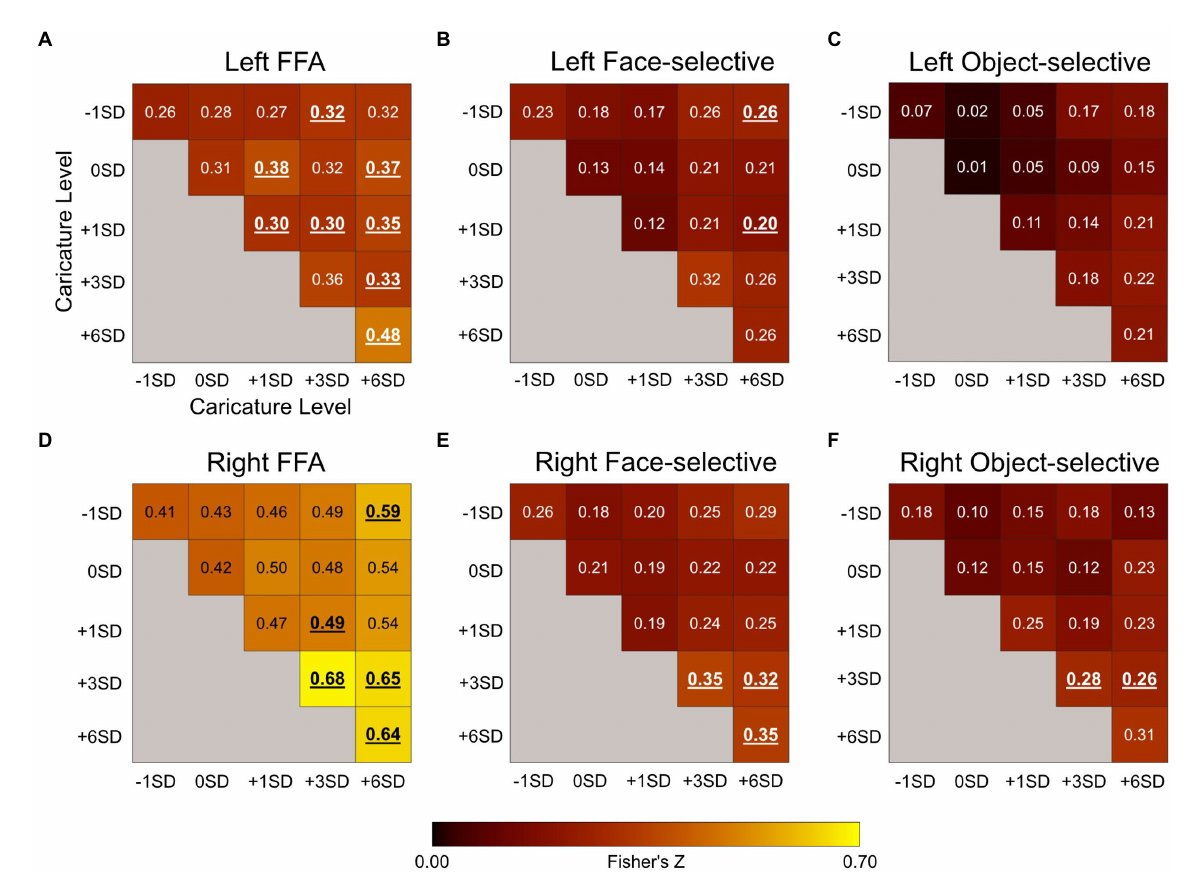
FIGURE 6 Plots showing the Fisher’s Z for the correlation coefficients between β maps corresponding to the 5 upright levels of caricature from the MVPA analysis in the left FFA (A) , the left face-selective voxels (B) , left object-selective voxels (C) , the right FFA (D) , right face-selective voxels (E) , and the right object-selective voxels (F) . The diagonal reflects the average correlations between the response patterns to stimuli of the same caricature level, whilst the off-diagonal reflects correlations between different caricature levels. Only between-scan correlations were assessed. Values in bold and underlined were significantly greater than 0 at a group level, measured using one-sample t -tests (Bonferroni-corrected a = .003 ̇ ). Font colour for display purposes